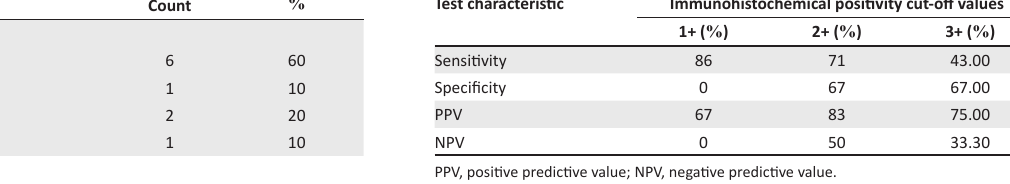
FIGURE 1: Hematoxylin and eosin (H&E) stain of positive high-grade non-Hodgkin lymphoma cell used as a control with positive FISH results for MYC rearrangement. (a) 4× magnification, (b) 10× magnification and (c) 40× magnification all stained by the routine H&E stain. (d, e) Showing positive results for the MYC mouse monoclonal antibody 9E10 immunohistochemical stain at 10× and 40× magnification. There is crisp nuclear staining of the cells. TABLE 3: A summary of the staining intensity and extent of the 10 Burkitt lymphoma cases. Staining feature Count